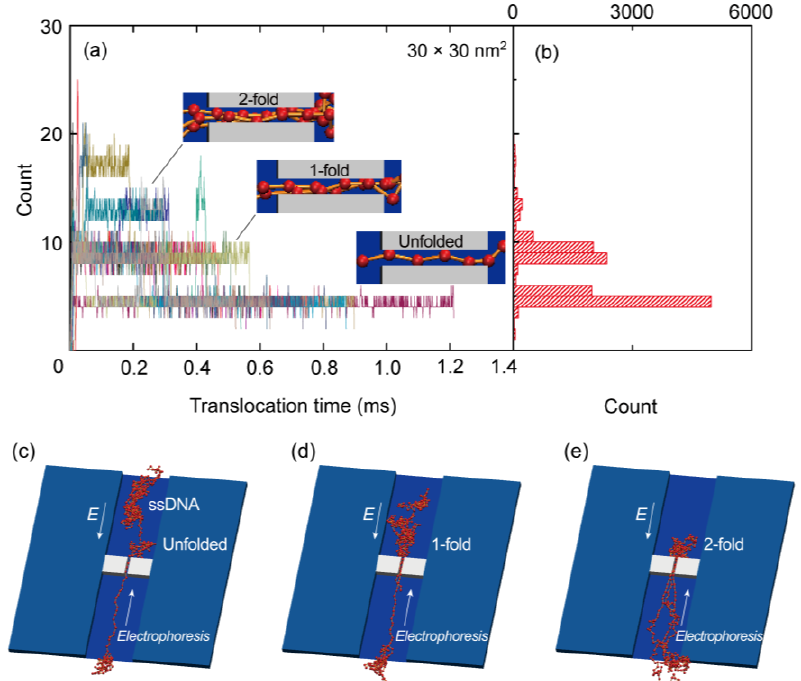
( b ) histogram of the number of beads in a 30 × 30 nm 2 cross-section nanopore, obtained from 20 runs of the Langevin dynamics simulation; A leading head enters the pore at t = 0 s and the time elapsed is recorded until the end bead leaves the pore. Illustrations of the entire ssDNA chain are also presented, showing ( c ) unfolded; ( d ) 1-fold; and ( e ) 2-fold